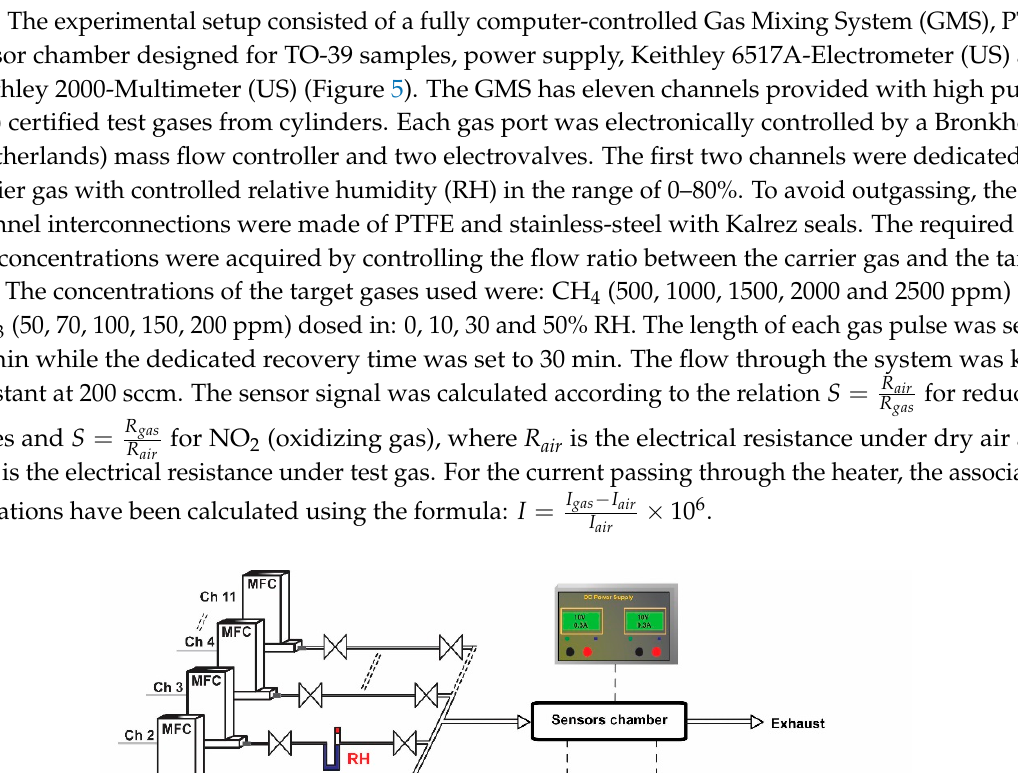
Figure 13. ( a ) Temperature dependence of sensitivity for 50 nm TiO 2 sensor after exposure to CO, CH 4 , NO 2 , NH 3 , SO 2 , ( b ) Electrical resistance and current response of TiO 2 gas sensors exposed to different concentrations of CH 4 and NH 3 under 0% RH at 480 °C and ( c ) Sensor signal for 10 nm and 50 nm thickness TiO 2 sensors.